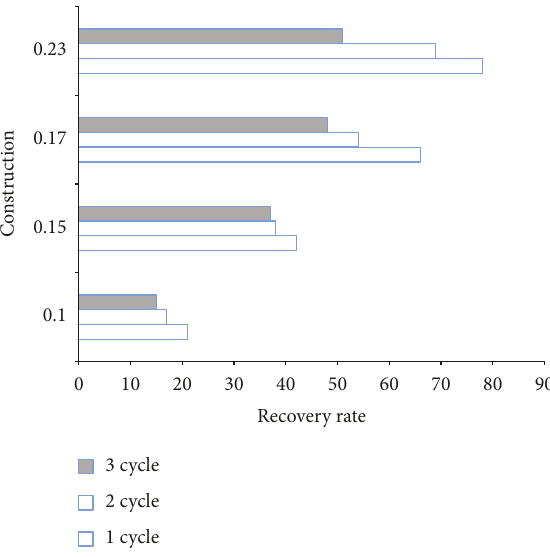
Figure 4: Filter recovery